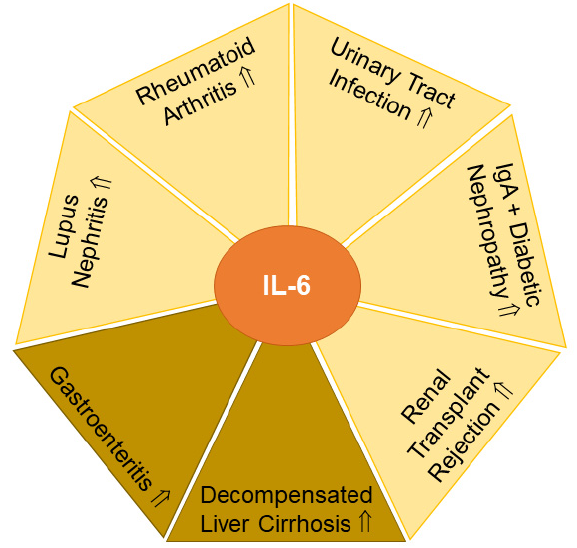
Figure 5. IL-6 levels in urine (yellow) and feces (light brown) have potential to serve as biomarkers for the indicated diseases. Elevated ( ⇑ ) IL-6 levels in urine or feces in patients compared to the respective controls are